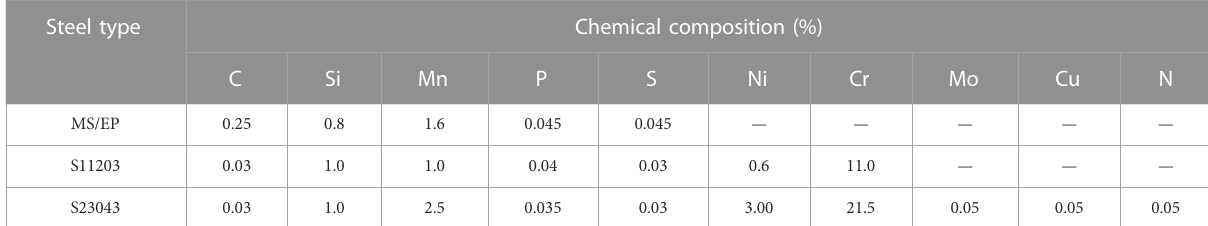
TABLE 2 Chemical composition of